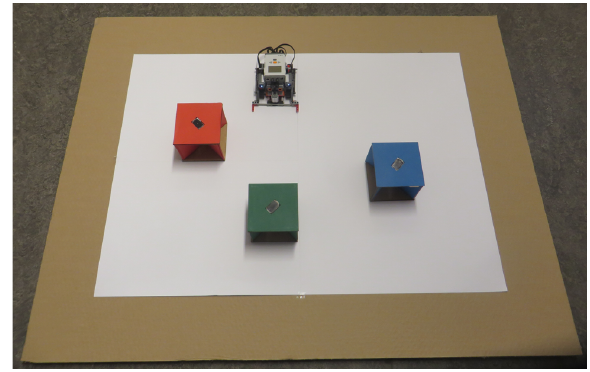
Fig. 2. Setup of the three coloured cubes on the 1.8 square meter large white area that the autonomous robot needs to push onto the